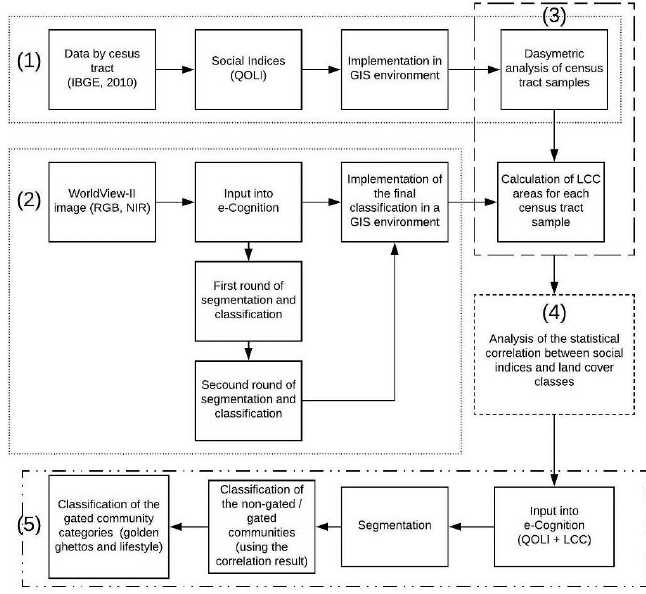
Figure 2. Methodological flow